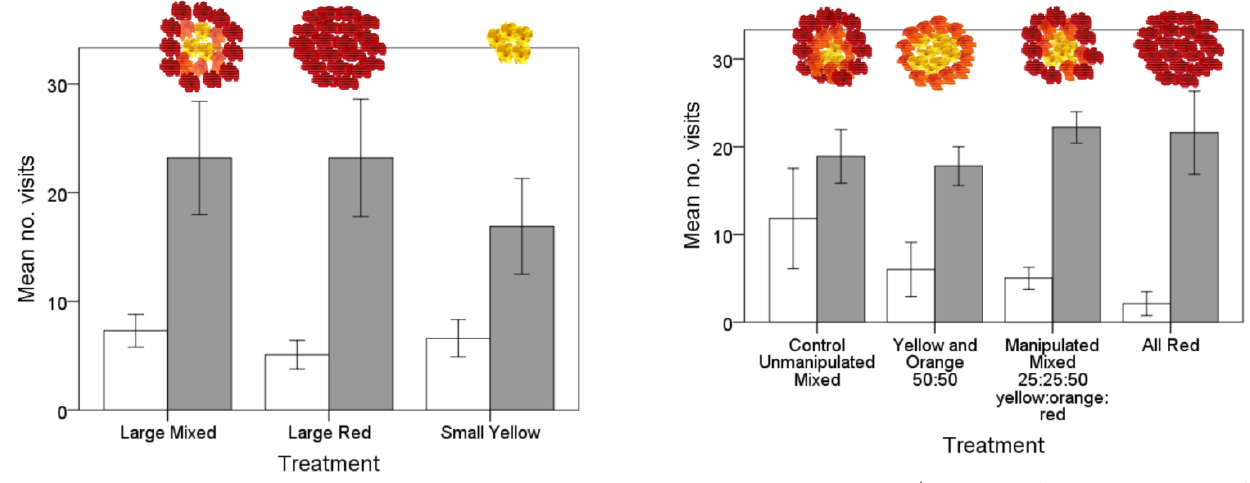
F IGURE 3. Mean (± SE) pollinator visitation of inflorescences by study species. Highest visitation by D. iulia (white bars) observed at Large Mixed plants while H. melpomene (grey bars) visited both Large Mixed and Large Red inflorescences more than Small Yellow.